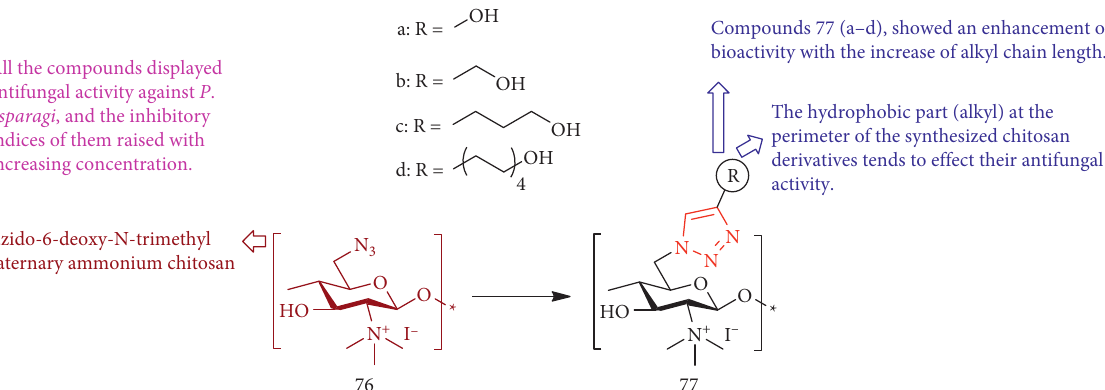
Figure 29: Chemical structure of novel triazolyl-functionalized chitosan derivatives with different chain lengths of aliphatic alcohol substituent.